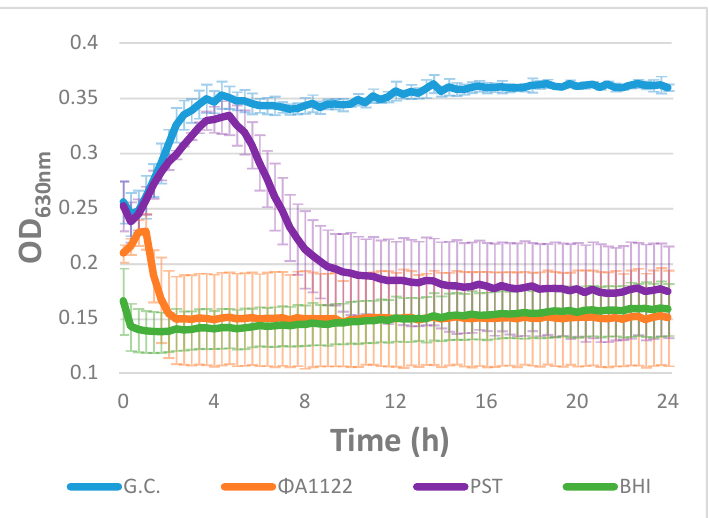
Figure 1. Lysis curve of EV76 cultures infected by phages. A Y. pestis EV76 bacterial suspension (90 µL of 10 8 CFU/mL) divided in a 96-well microplate was infected with two different Y. pestis -specific phages ( ϕ A1122 and PST; 10 µL of 10 7 PFU/mL) at an MOI of 0.01 (time 0 is time of infection). Growth/lysis curves were assessed by tracking the OD 630nm at 37 °C for 24 h in 15-min intervals using a Spark 10 M plate reader. The results are representative of one of three independent biological replicates. Values are the average of four replicate wells in the same experiment, and the error bars represent the standard deviation (STDEV). G.C. = Growth Control.